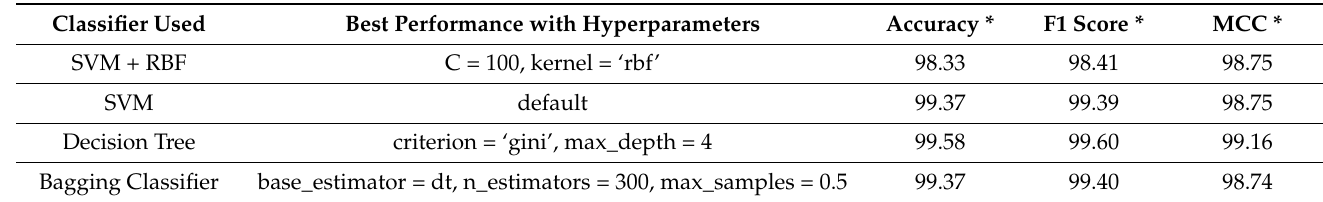
Table 5. Estimated performance over Dataset-2 under